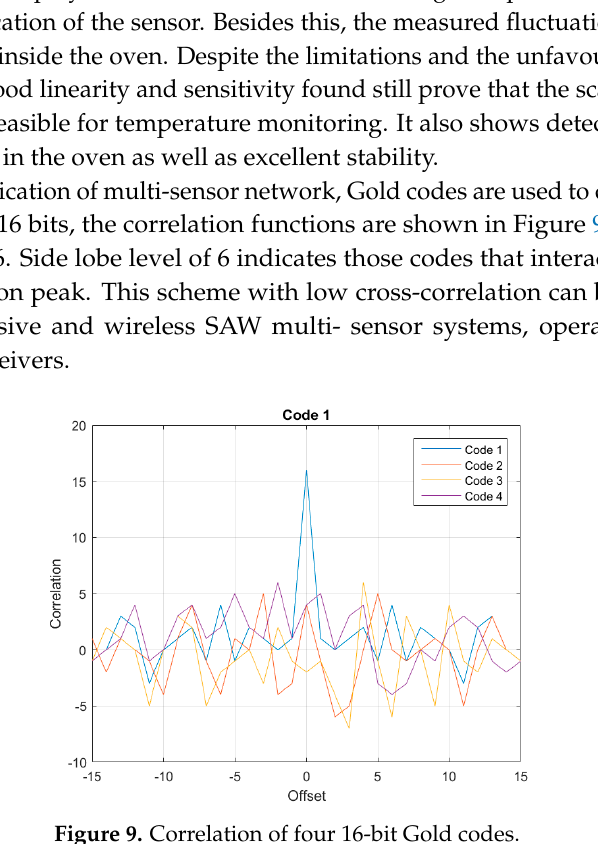
Figure 9. Correlation of four 16-bit Gold codes.